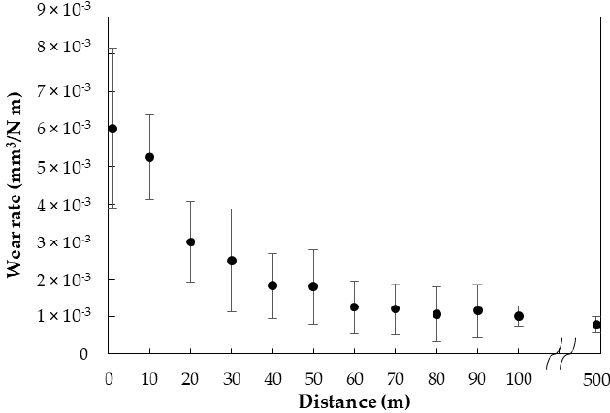
Figure 7. Evolution of wear rate with sliding distance.